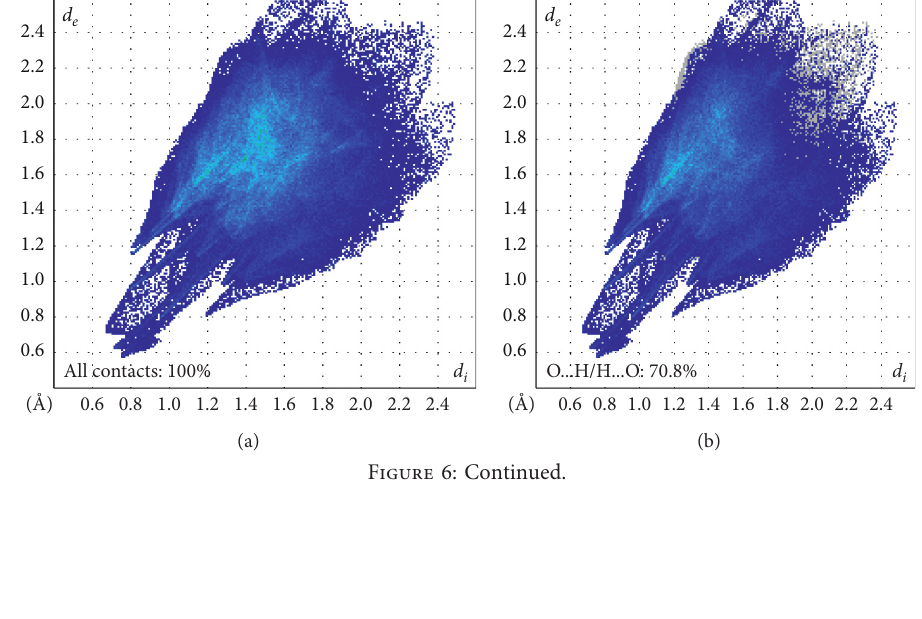
· 4.21H 2 O compound.